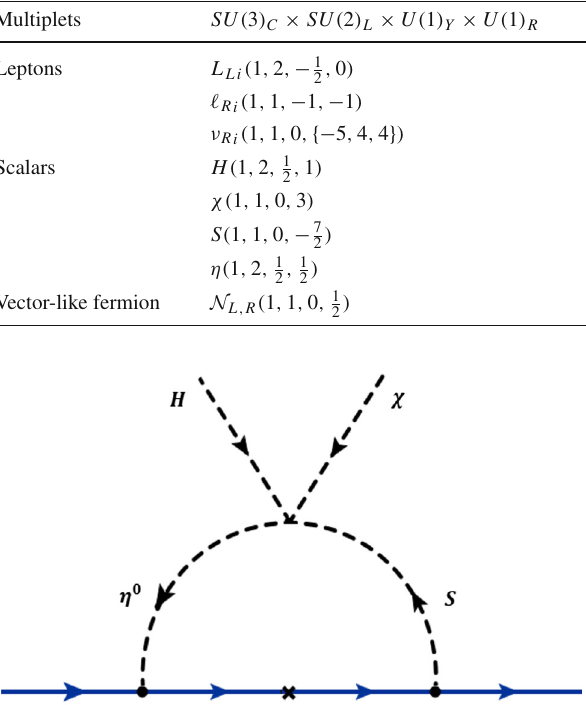
Table5 Quantumnumbersofthefermionsandthescalarsinscotogenic